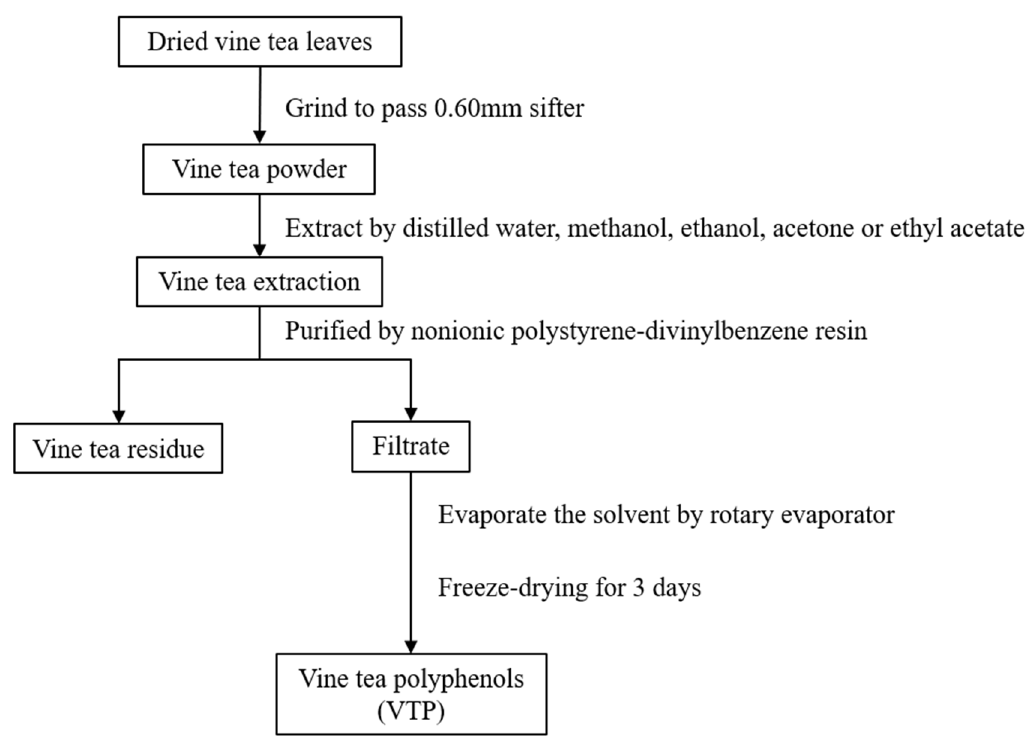
Figure 1. Diagram of vine tea polyphenol (VTP) extraction. All vine tea leaves from di ff erent locations were freeze-dried to ensure the same moisture content.